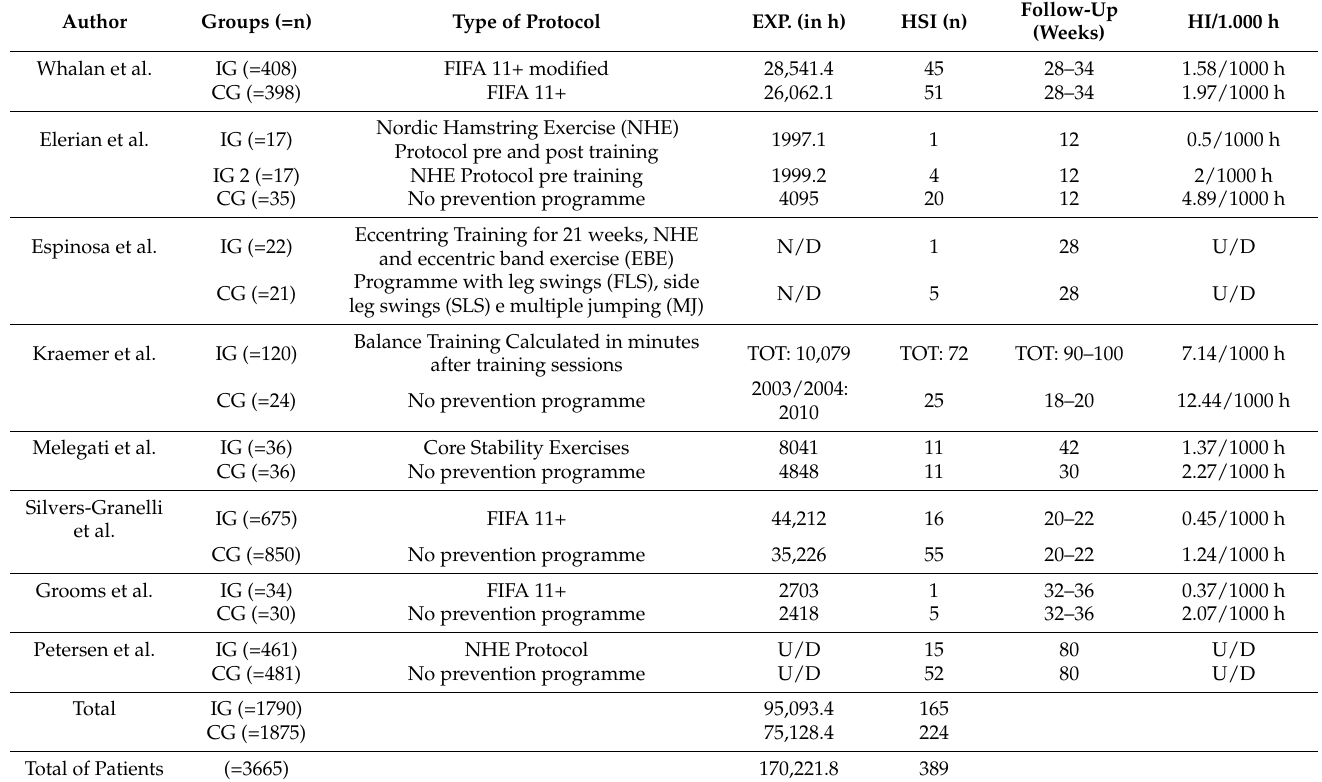
Table 3. Detailed preventive interventions performed in the studies included in the